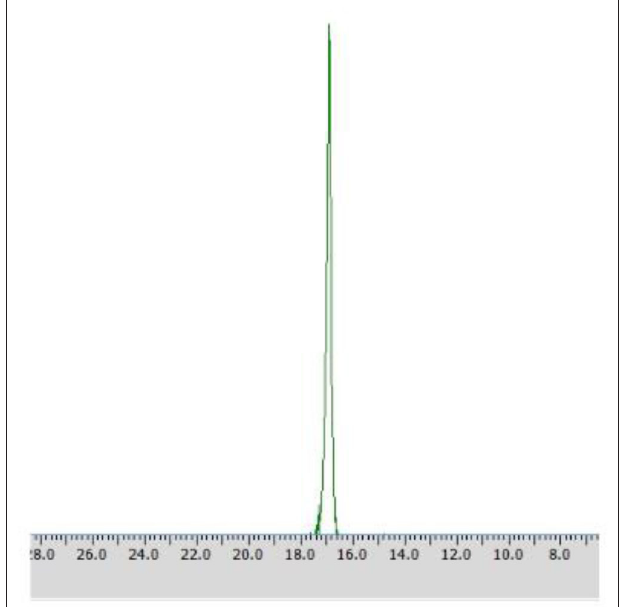
FIGURE 6 | 31 P NMR spectrum of post-bioconversion mixture recorded with the addition of CSA, after the biotransformation of